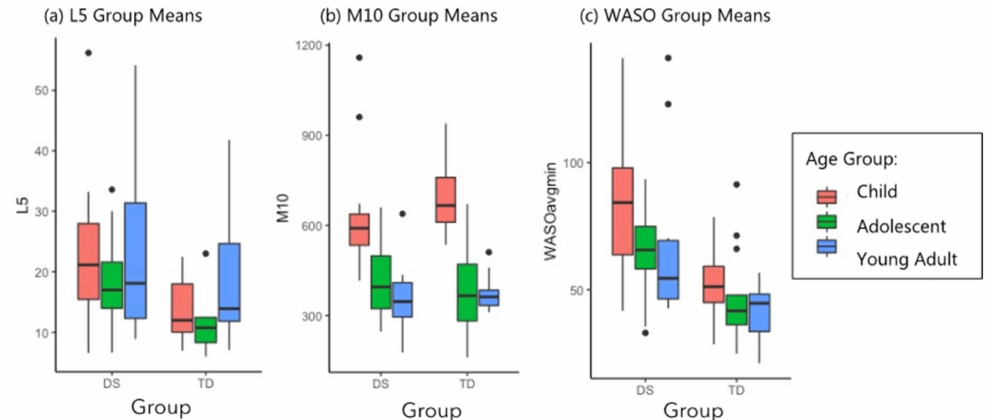
Figure 4. Group means by age for L5, M10, and WASO. ( a ) The L5, or the sequence of least-active 5 h in the 24-h period was higher for participants with DS ( p < 0.01). ( b ) There were no significant group differences for M10, or the most active 10-h sequence during the 24-h period ( p > 0.05). ( c ) The WASO ANOVA indicated significantly more minutes awake after sleep onset for participants with DS than for participants with TD ( p < 0.001).